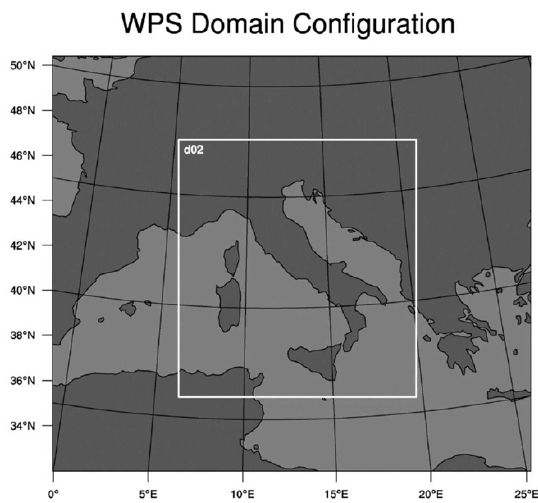
Figure 1. Spatial domains of the Weather Research and Forecasting (WRF) model running at the Institute of Methodologies for Environmental Analysis of the National Research Council of Italy (IMAA-CNR).